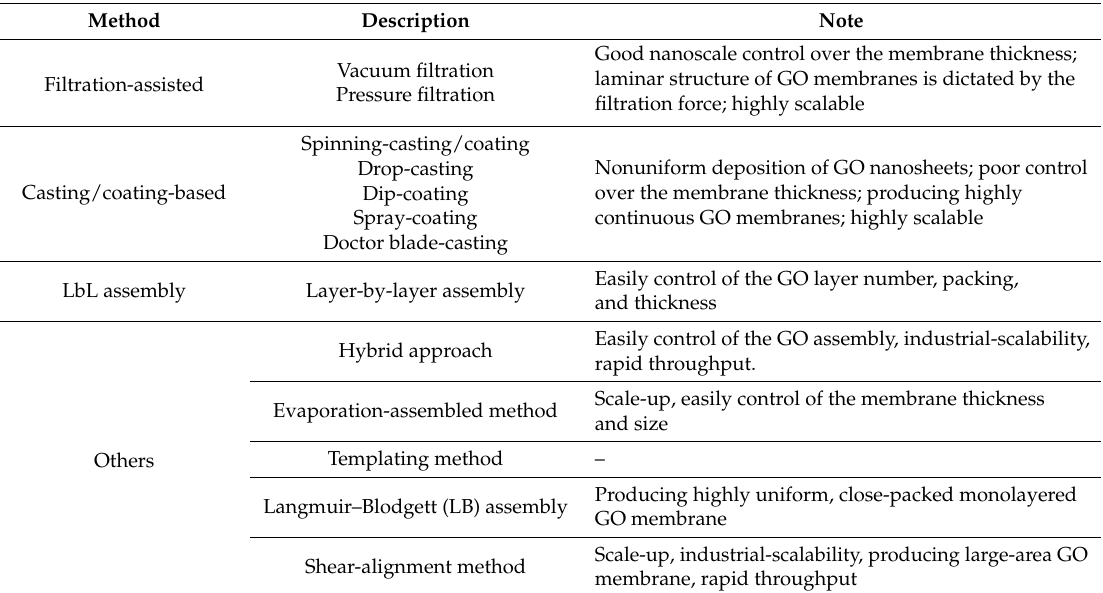
Table 3. Methods for the preparation of GO